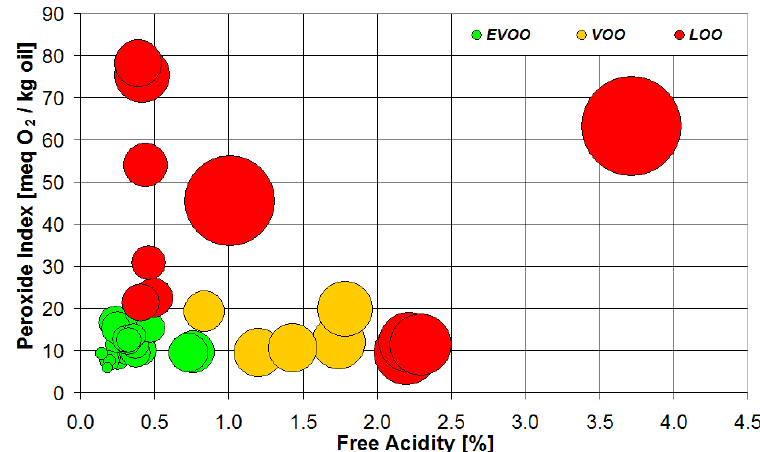
Figure 15. Emulsion electrical conductance at 23.5 °C using the HAS reagent as function of free acidity and peroxide index for the full set of olive oil samples.